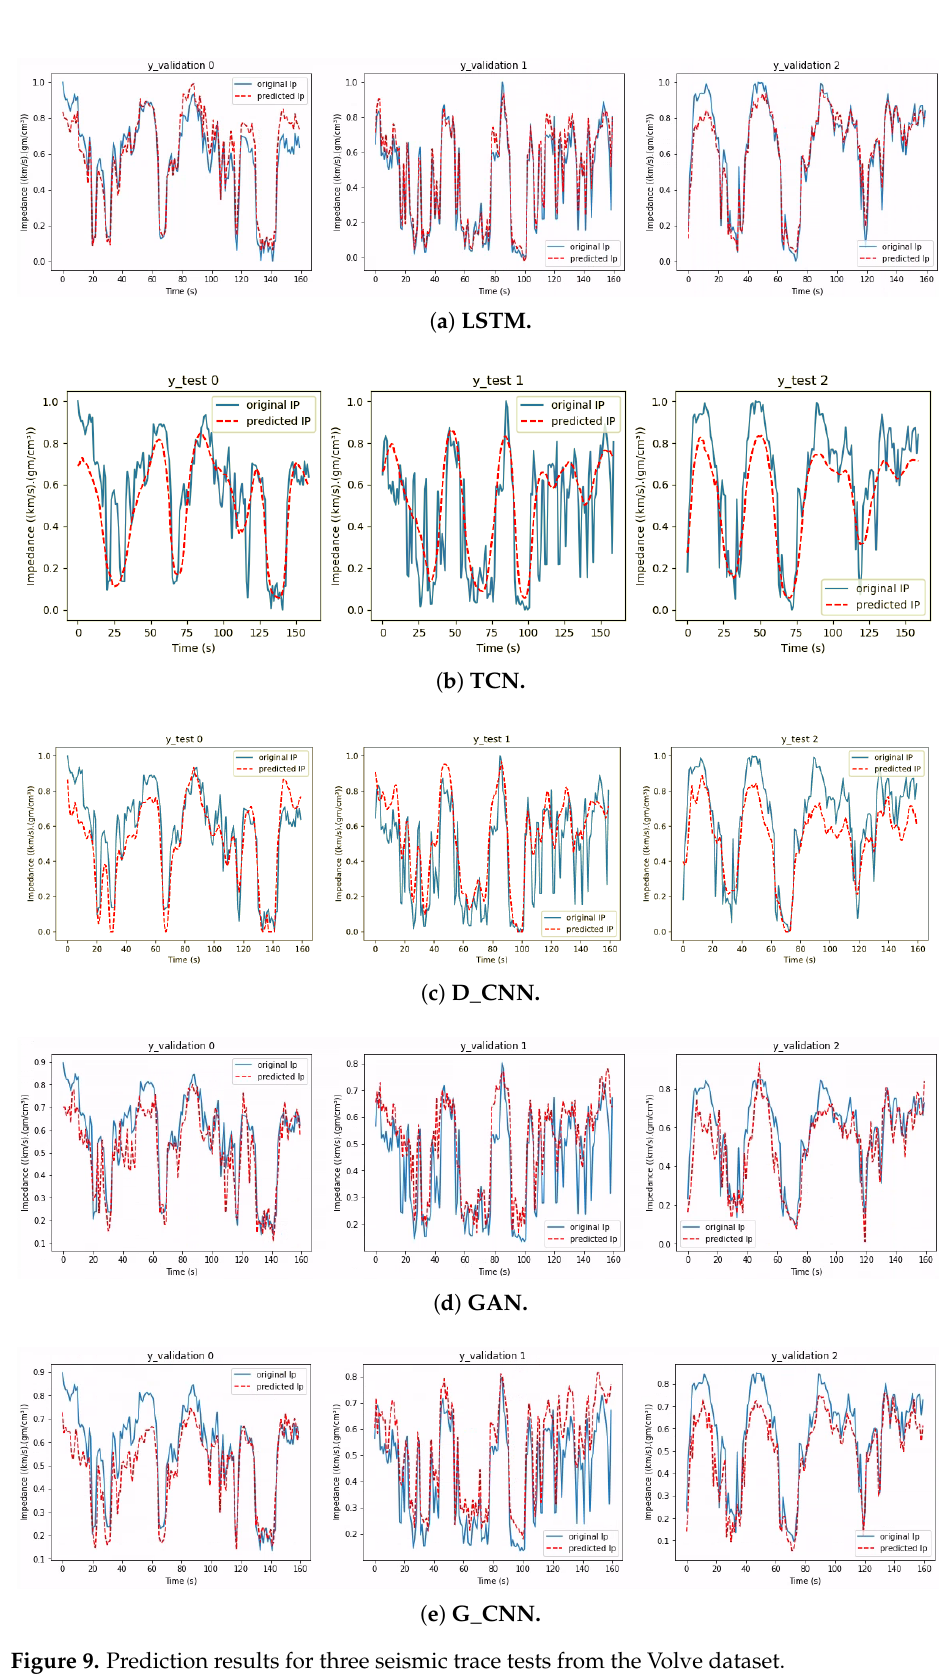
Figure 9. Prediction results for three seismic trace tests from the Volve